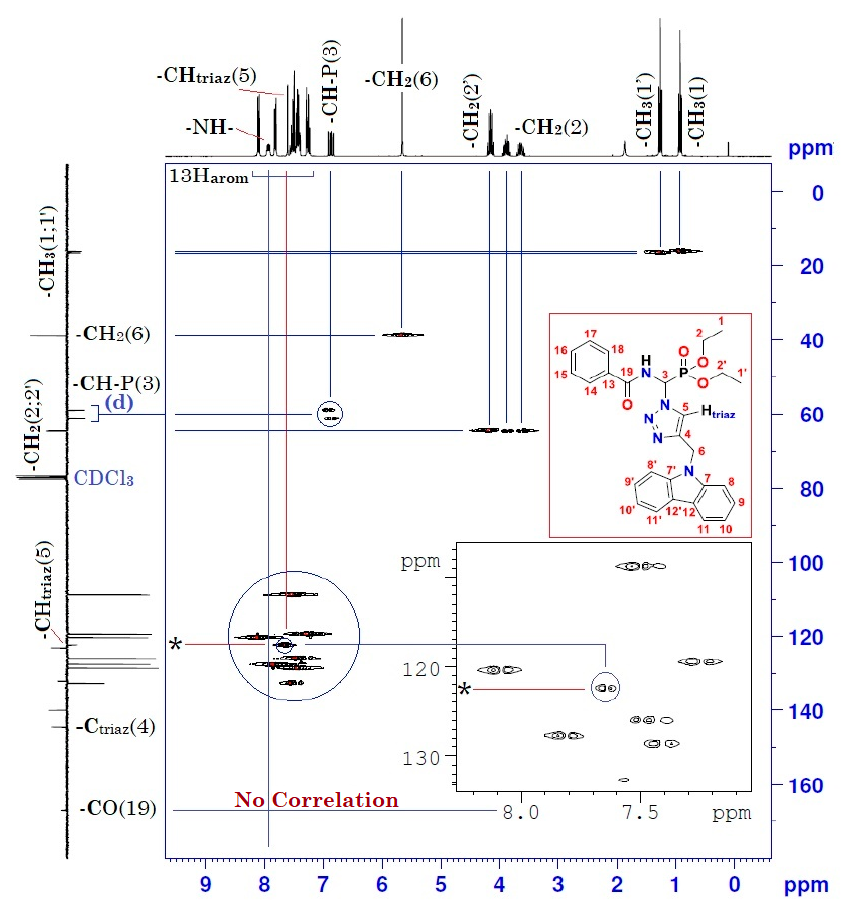
Figure 5. Heteronuclear 1 H- 13 C 2D spectrum of compound ( 3 ).